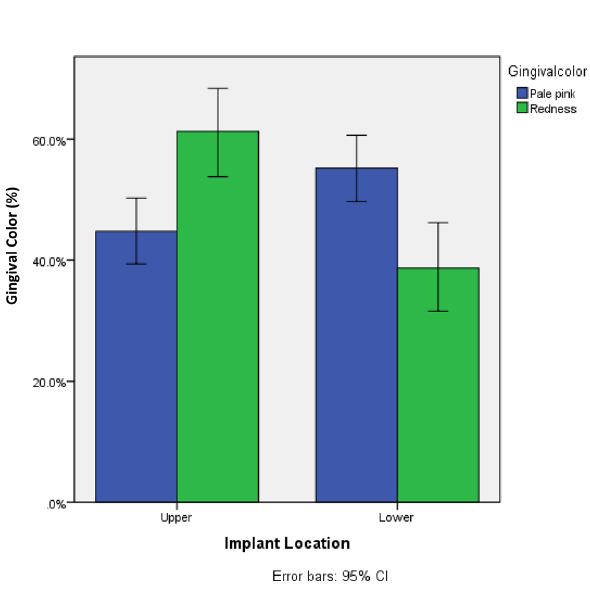
Figure 5. Percentage of gingival color (pale pink vs. redness) based on implant location (maxillary vs.